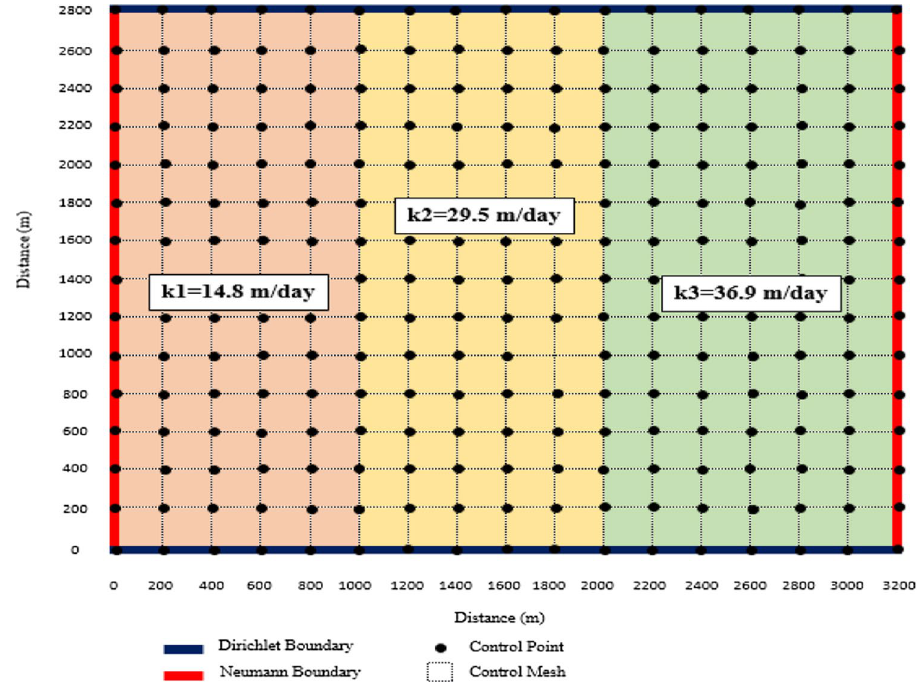
Fig. 2 Schematic view of the hypothetical aquifer under injec- tion test with different hydraulic conductivity (scenario